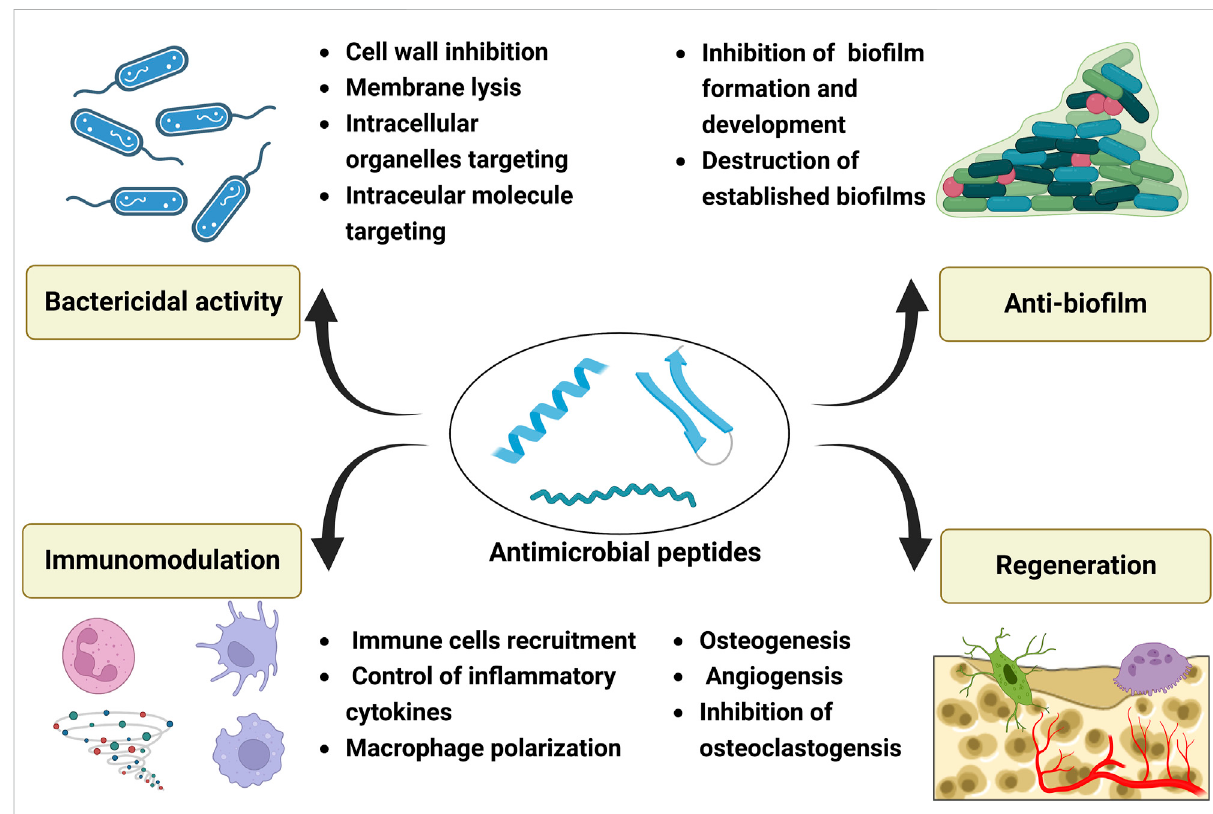
FIGURE 3 Potential effects of antimicrobial peptides for bone tissue engineering, and these effects can be mainly divided into four groups: bactericidal activity, anti-bio fi lm properties, immunomodulation and regenerative functions. Created with